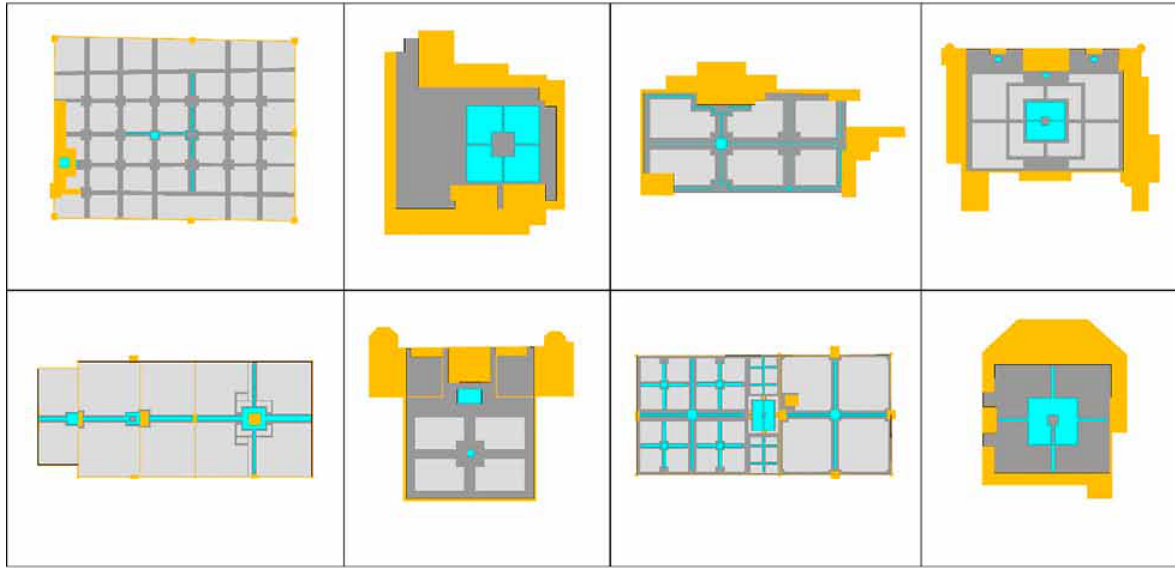
fig. 1. Variation of urban forms and plazas of the Mughal gardens evolving from the Charbagh archetype (abdul latip et al.